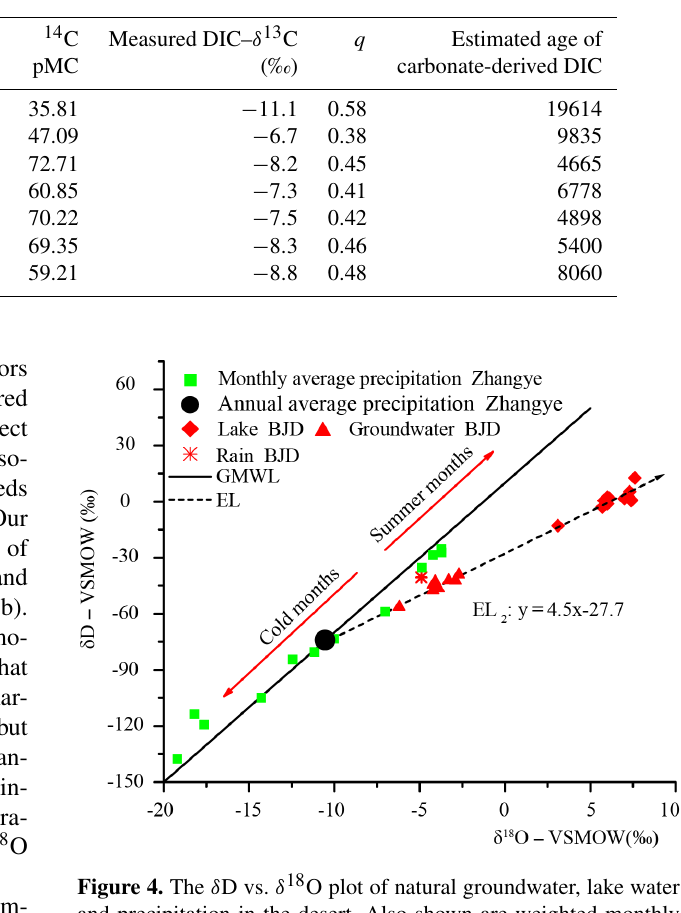
Table 3. Radiocarbon and 3 H contents of groundwater samples.